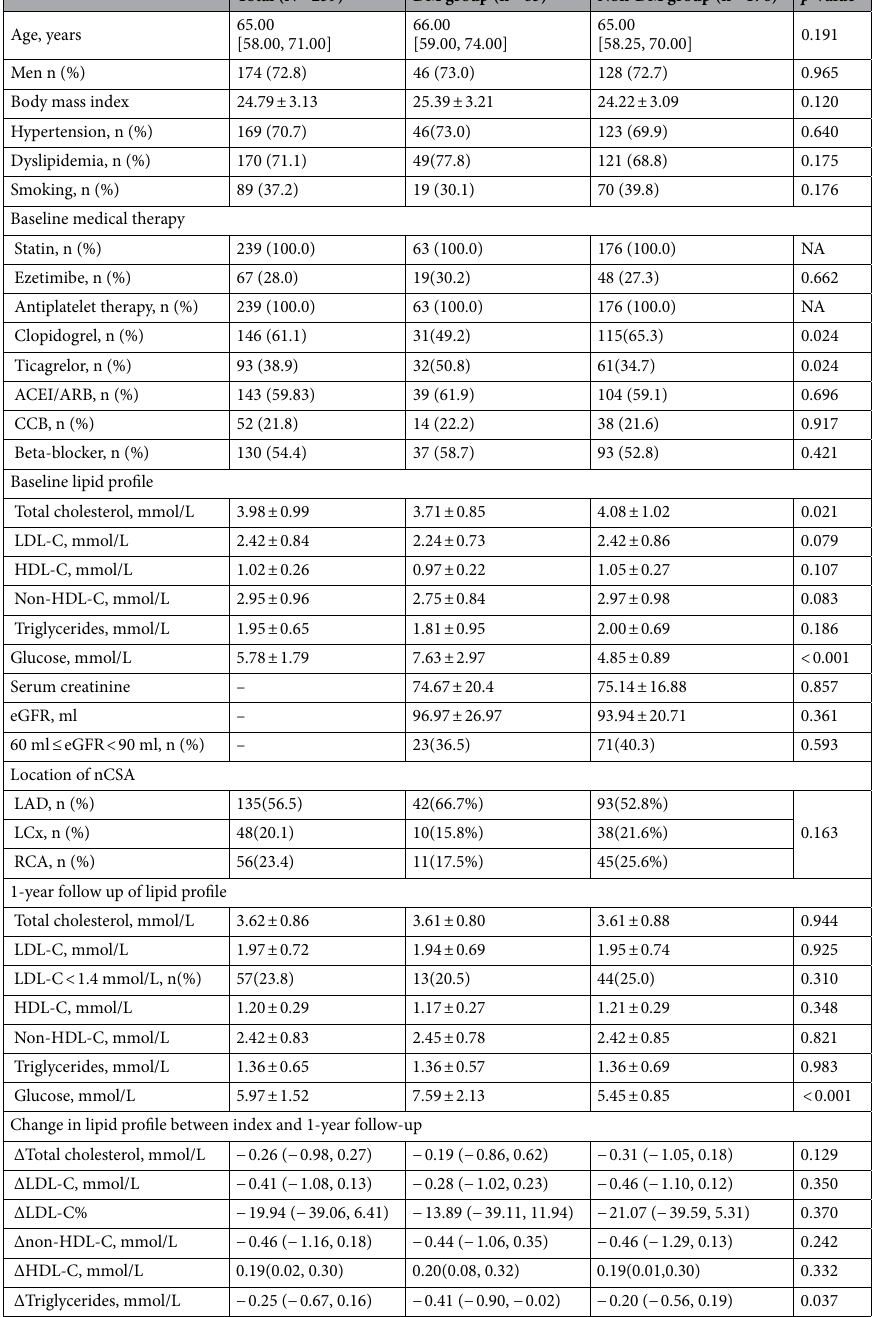
Table 1. Patient demographics in phase I analysis. Values are expressed as the median (interquartile range) for continuous variables with abnormal distribution and described as the mean ± standard deviation with normal distribution, or frequency (percentage) for categorical variables in the table. ACEI angiotensin-converting enzyme inhibitor, ARB angiotensin receptor blocker, CCB calcium channel blocker, DM diabetes mellitus, eGFR estimated glomerular filtration rate, HDL-C high-density lipoprotein cholesterol, LDL-C low-density lipoprotein